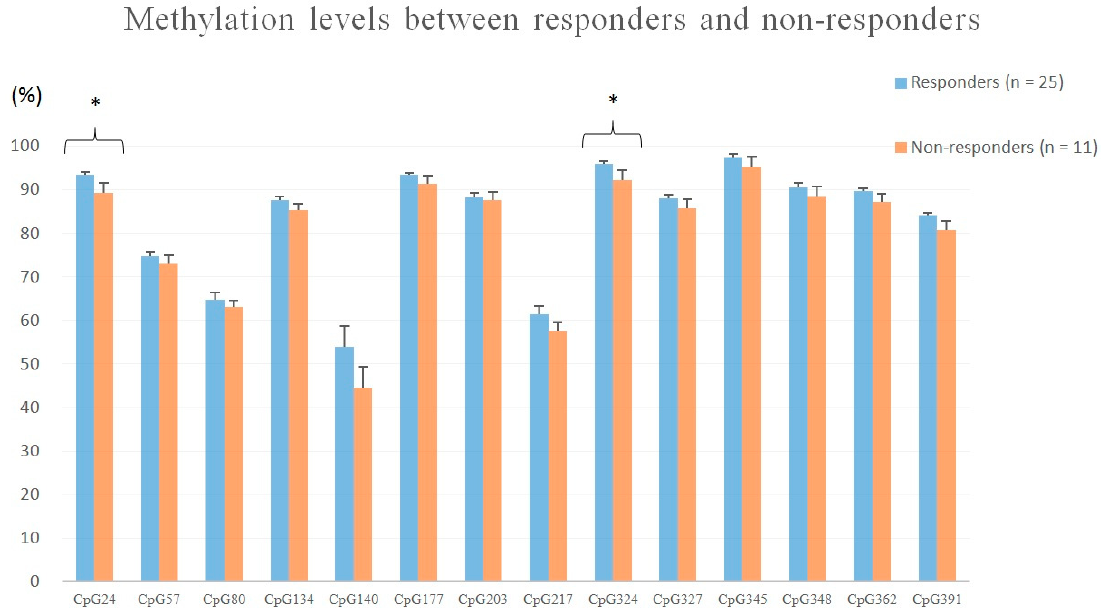
Figure 2. Methylation levels of 14 CpG sites of BDNF exon IX between drug responders and non-responders. (* p <